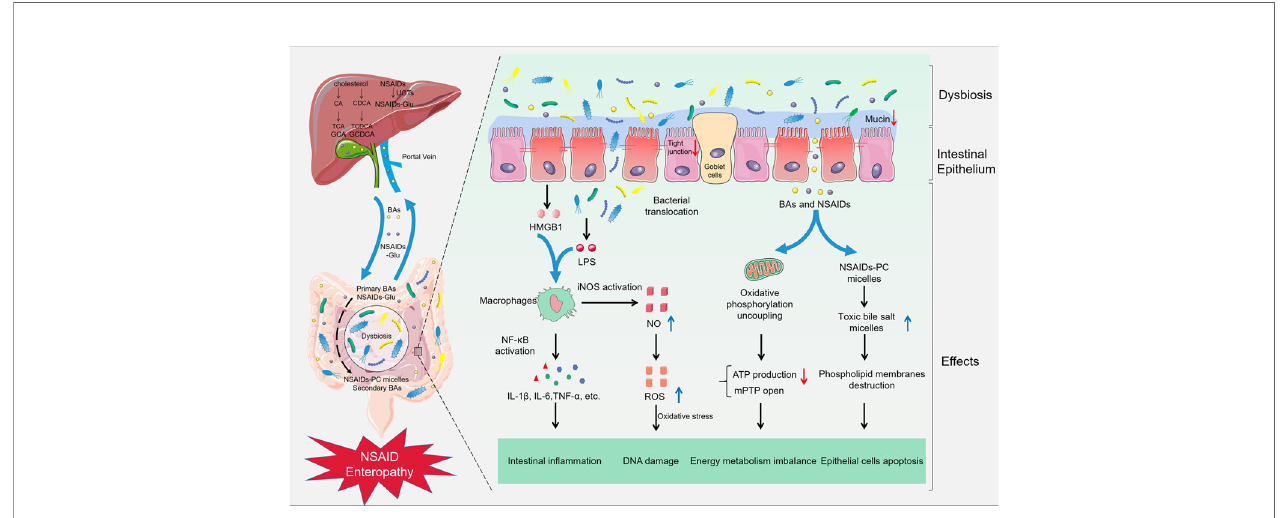
FIGURE 1 | Gut microbiota in NSAID enteropathy. The supplement of NSAIDs could lead to the gut barrier destruction, intestinal dysbiosis, and bacterial translocation. Subsequently, LPS from the Gram-negative bacteria and HMGB1 from the damaged epithelial cells combine with TLR-4, resulting in activation of NF- k B through the MyD88-dependent pathway, increasing the production of cytokines such as TNF- a , IL-1 b , and IL-6, subsequently inducing intestinal in fl ammation in NSAID enteropathy. Furthermore, the activation of NF- k B also can up-regulate the expression of iNOS and produce excessive NO, fi nally damage the DNA and enzymes of epithelial cells in oxidative stress. Meanwhile, NSAIDs can cause an uncoupling of oxidative phosphorylation in the mitochondria and reduce ATP production and open the mitochondrial permeability transition pore (mPTP), which leading to energy metabolism imbalance. Besides, NSAIDs can competitively bind to phosphatidylcholine (PC) with bile acids, and increase the formation of toxic bile salt micelles, destroy the phospholipid membrane, and contribute to the pathogenesis of NSAID